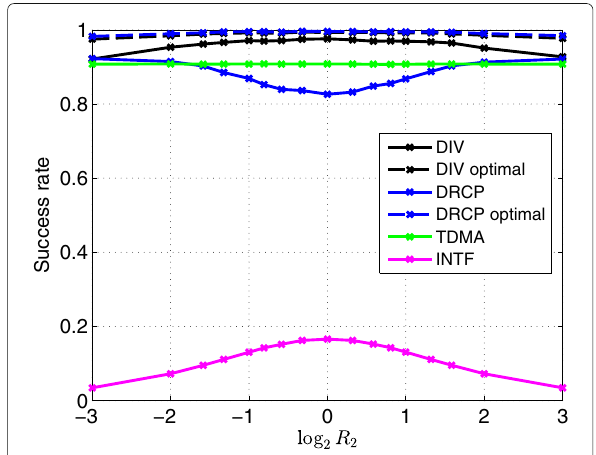
Fig. 7 Spectral efficiency of the studied approaches in the circuit power-dominated regime with S min 1 = S min 1 = 0.3 bits/Hz